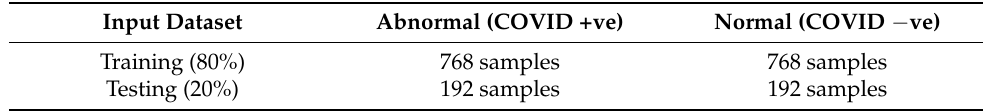
Table 1. Input Data Split and